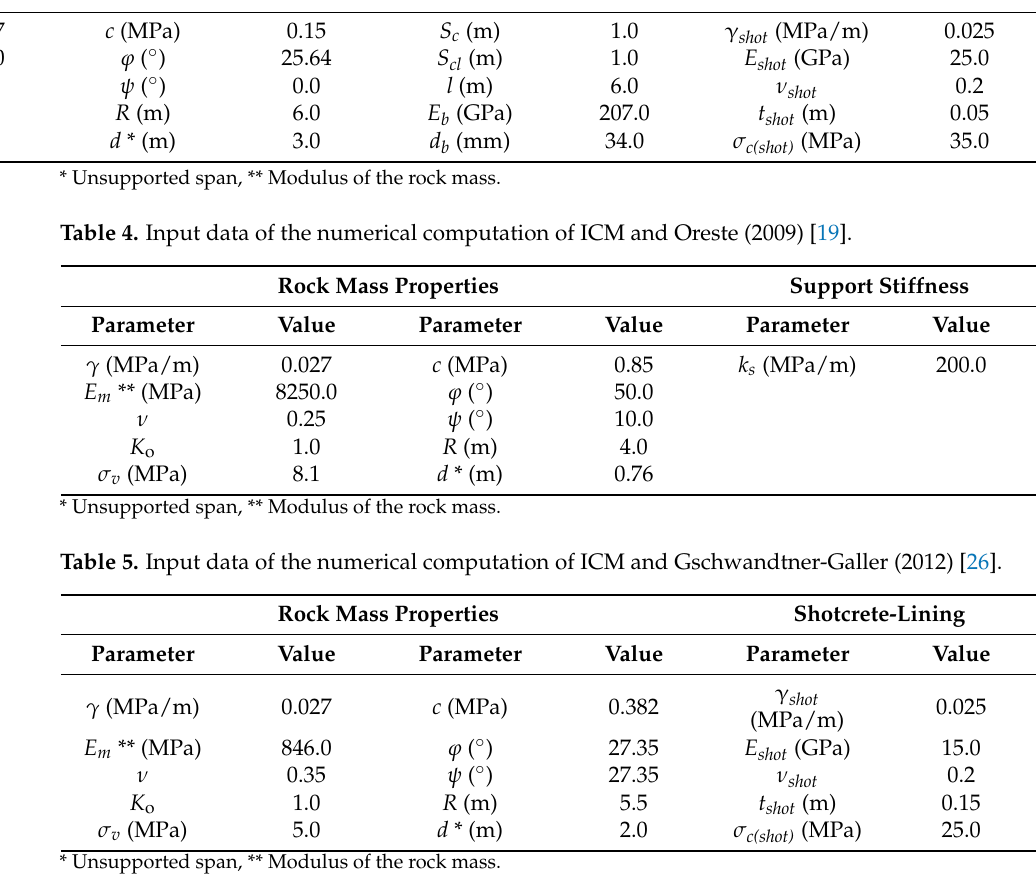
Table 3. Input data of the numerical computation of ICM and Rocksupport (2004) [20]. Rock Mass Properties